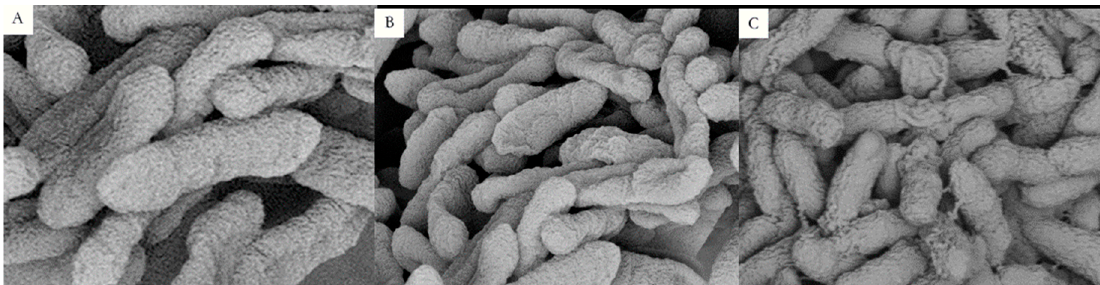
Figure 1. SEM images for Xoo after incubated using different concentrations of compound A 1 , ( A ) 0 µg/mL; ( B ) 50 µg/mL and ( C ) 100 µg/mL. Scale for A, B and C is 5 µm.